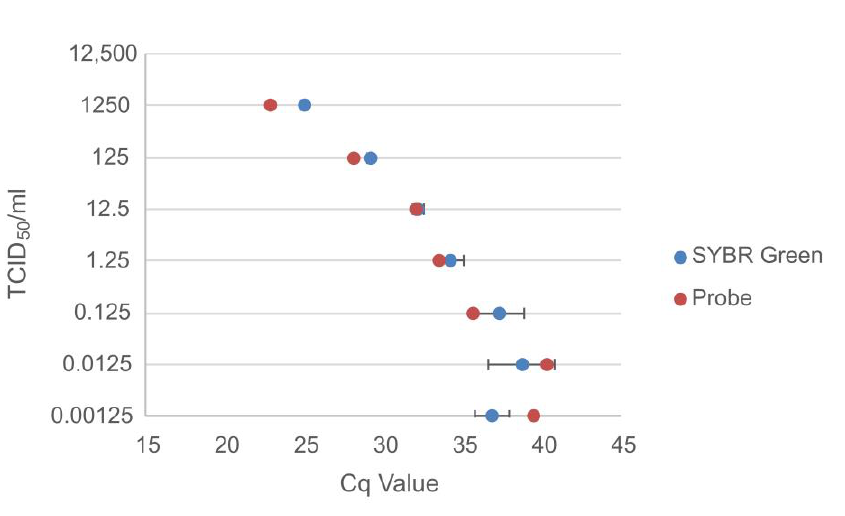
Figure 6. Comparison of the Cq values for the probe-based assay and the average Cq values for the SYBR Green assay for the titrated (TCID 50 /mL) serially diluted Marburg virus.